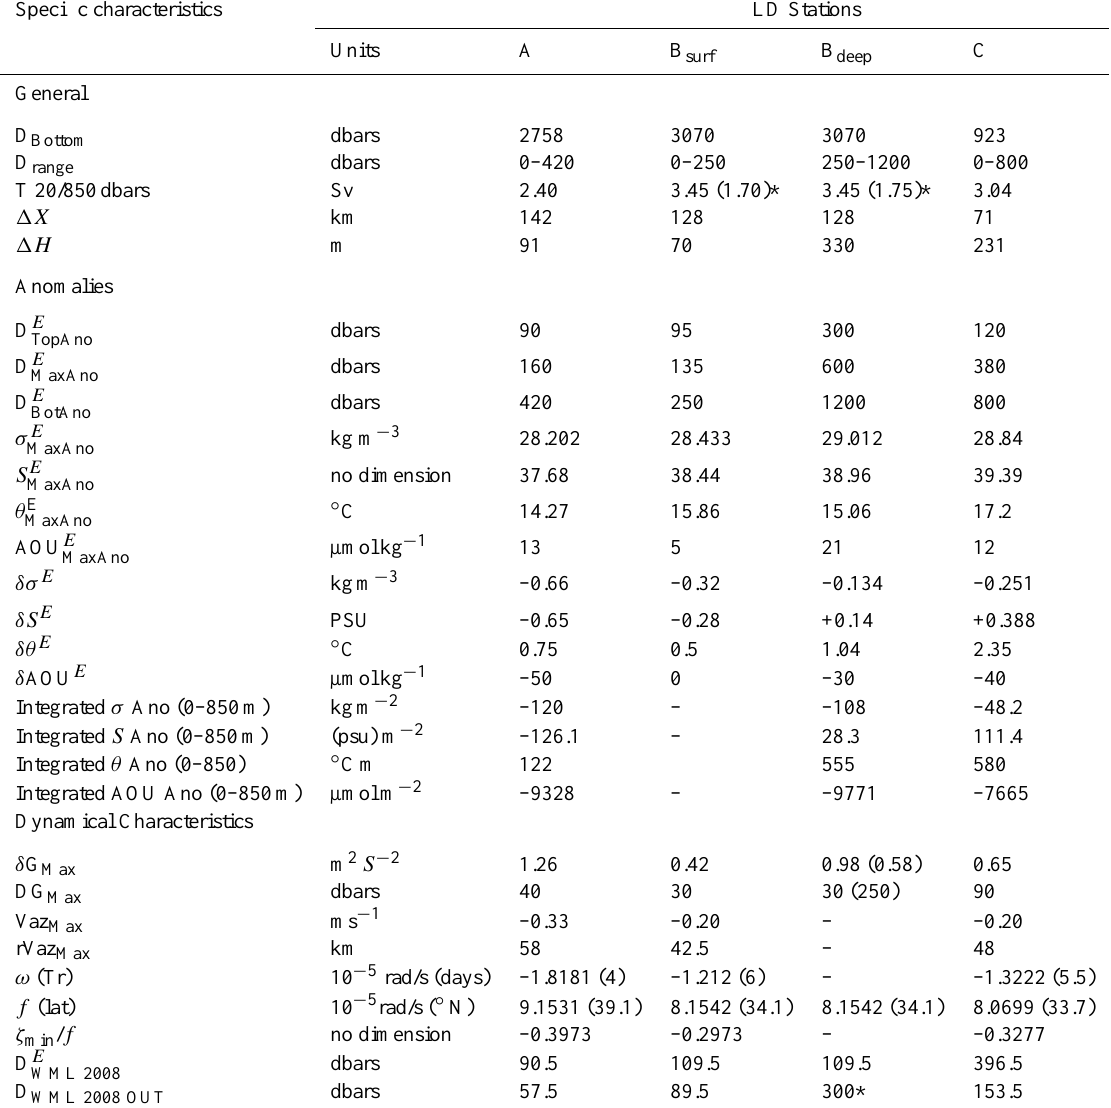
Table 2. Specific depth characteristics of the three studied eddies at the three LD stations A(130;186), B(2.71) and C(17.71). Numbers in brackets correspond to CTD casts “in” (i.e. near eddy axis) and “out”, respectively. As eddy B shows two pycnostads and an S anomaly ( S Ano) sign change, two parts, surface and deep, were distinguished. See Material and Methods for a detailed description of all specific